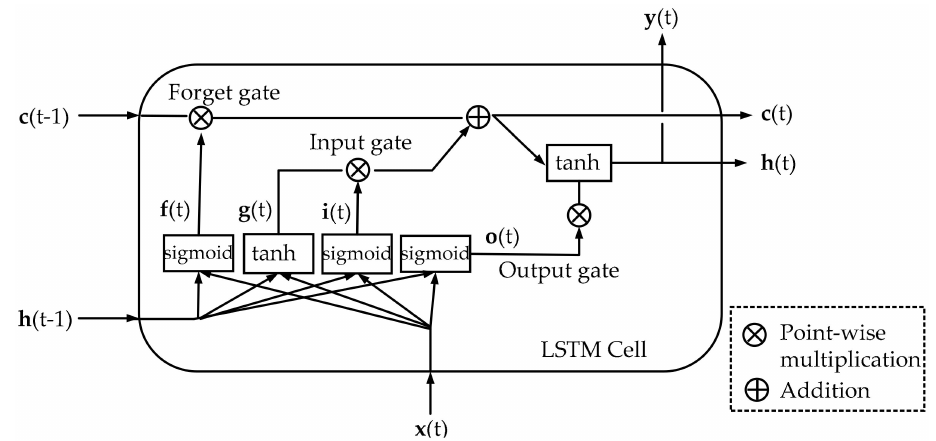
Figure 6. The structure of Long Short-Term Memory